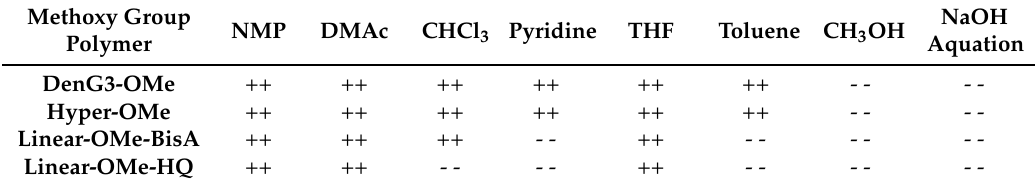
Table 1. Solubilities of DenG3-OMe , Hyper-OMe , Linear-OMe-BisA , and Linear-OMe-HQ . Methoxy Group